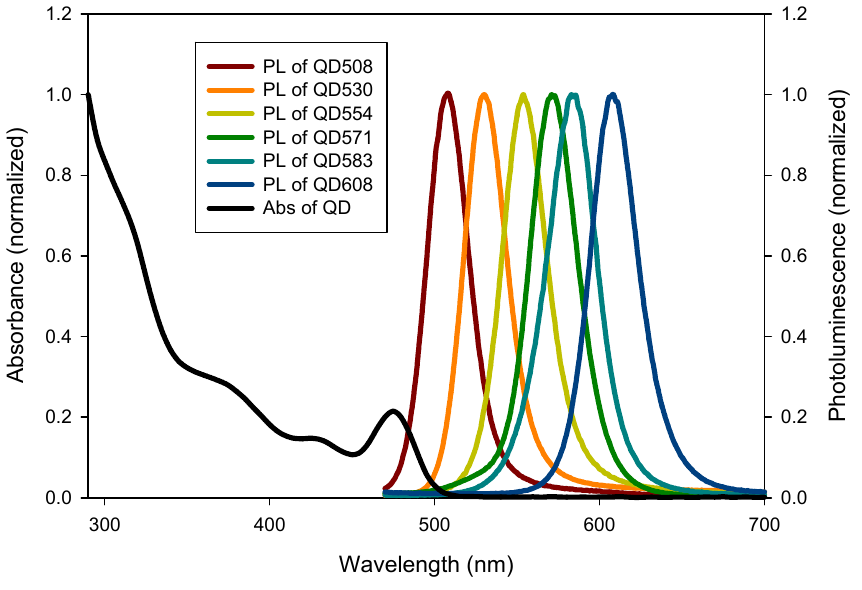
Figure 1. Absorption and emission of six different quantum dot